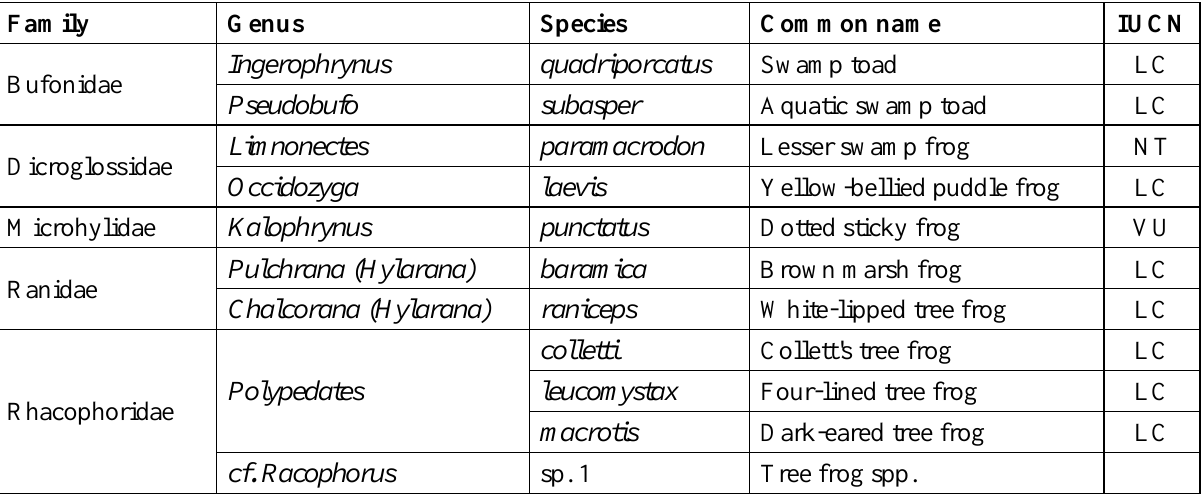
Table A7. List of amphibian (Amphibia; Anura) species recorded in the NLPSF, Sebangau, together with IUCN Red List classifications (LC = least concern; NT = near threatened; VU = vulnerable). No species identified to species level are listed in the Indonesian protected species list and none are Borneo endemics. Parentheses indicate